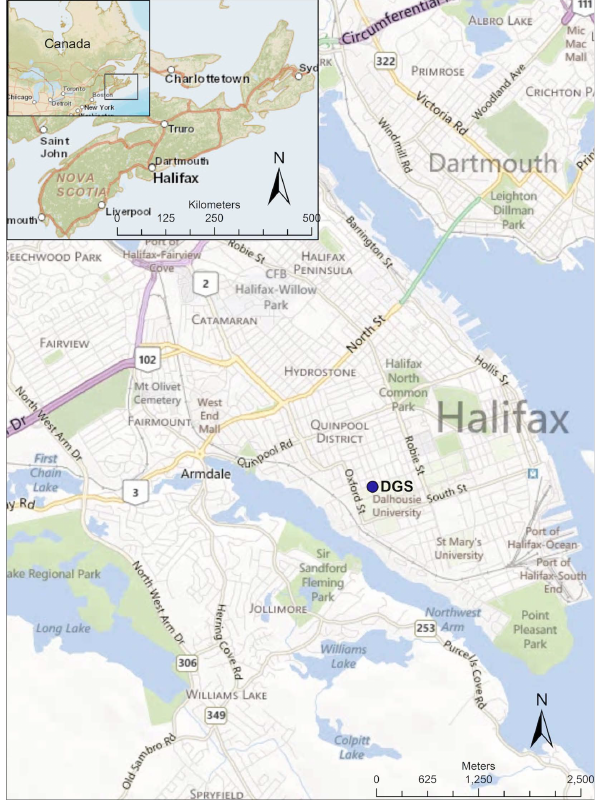
Fig. 1. Location of the DGS used during BORTAS-B (source of maps: free within